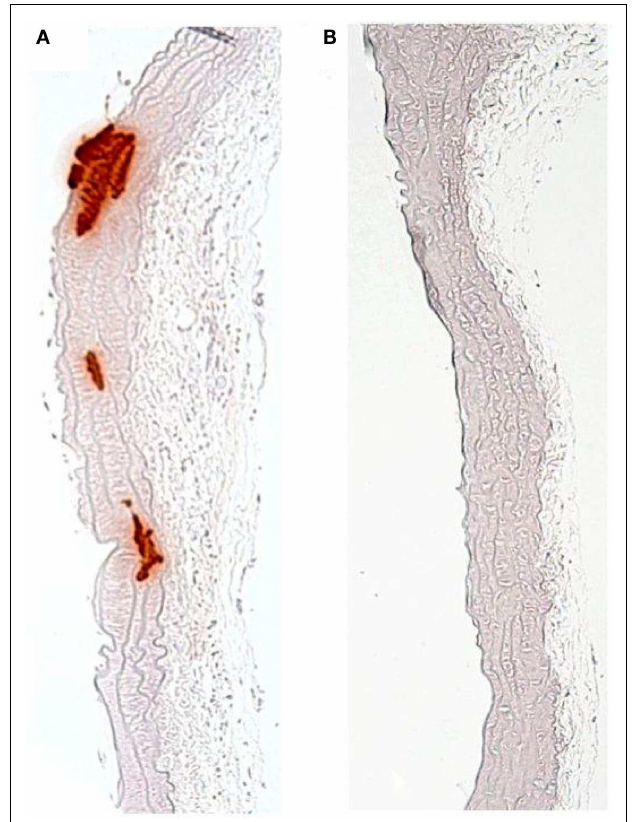
FIGURE 5 | Medial calcification of the aorta due to depressed levels of the calcification inhibitor pyrophosphate in the (A) Enpp1-null mouse, compared to (B) wild-type